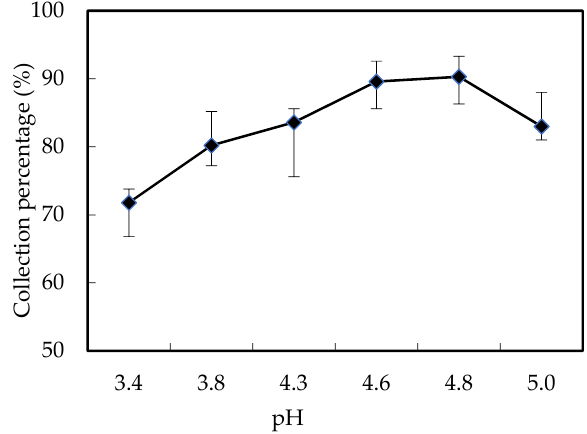
Figure 6. Influence of wastewater pH.